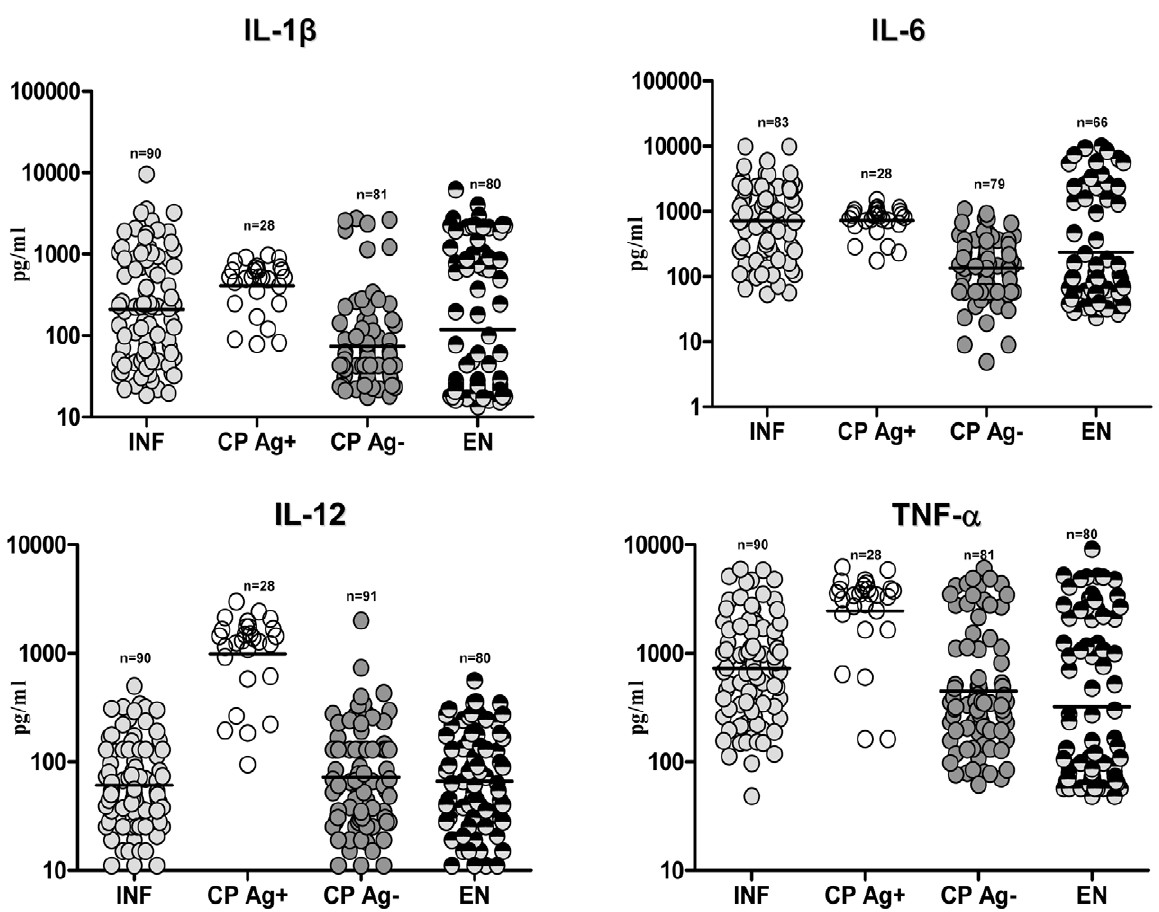
Figure 3. Filarial lymphedema is associated with elevated levels of inflammatory cytokines. Plasma levels of IL-1 b , IL-6, IL-12 and TNF- a from asymptomatic infected [INF] individuals; filarial lymphedema individuals with active infection [CP Ag + ]; filarial lymphedema individuals without active infection [CP Ag 2 ] and endemic normal [EN] individuals were measured by ELISA. Data are shown as scatter plots with the bar representing the geometric mean.